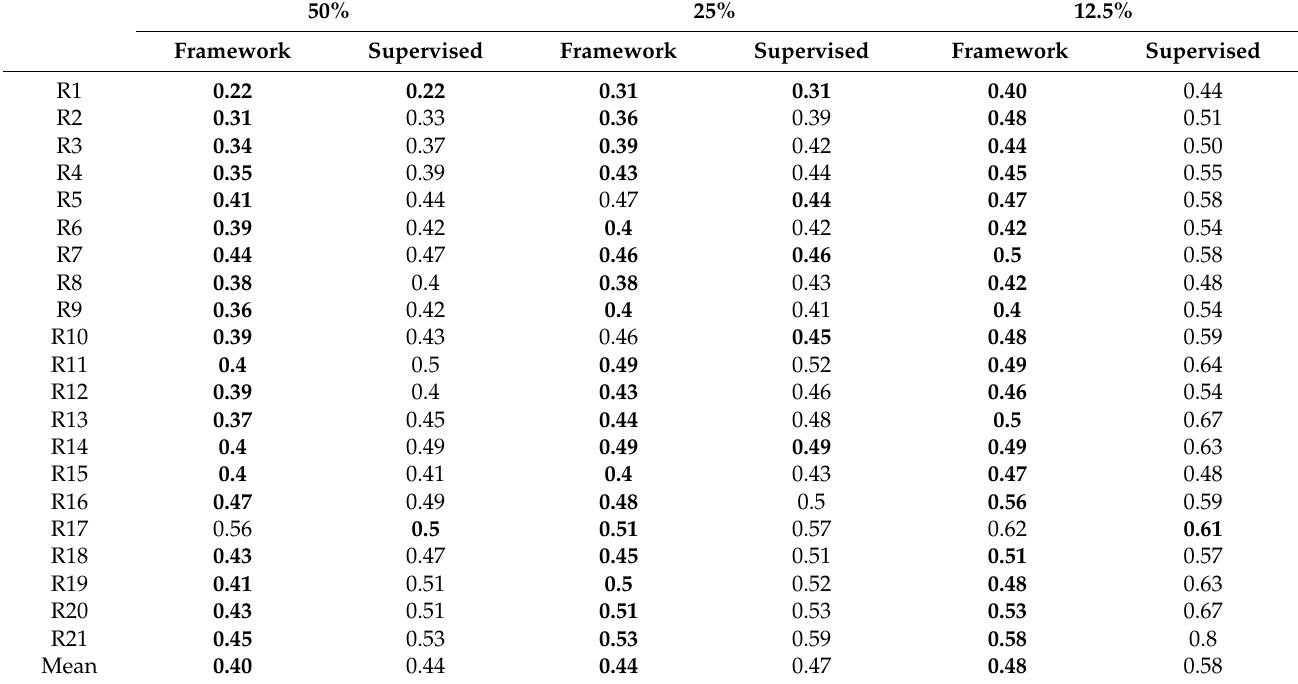
Table 4. The mean squared error (MSE) of models with feature selection (FS) trained on receiver no. 1. 50% 25% 12.5% Framework Supervised Framework Supervised Framework